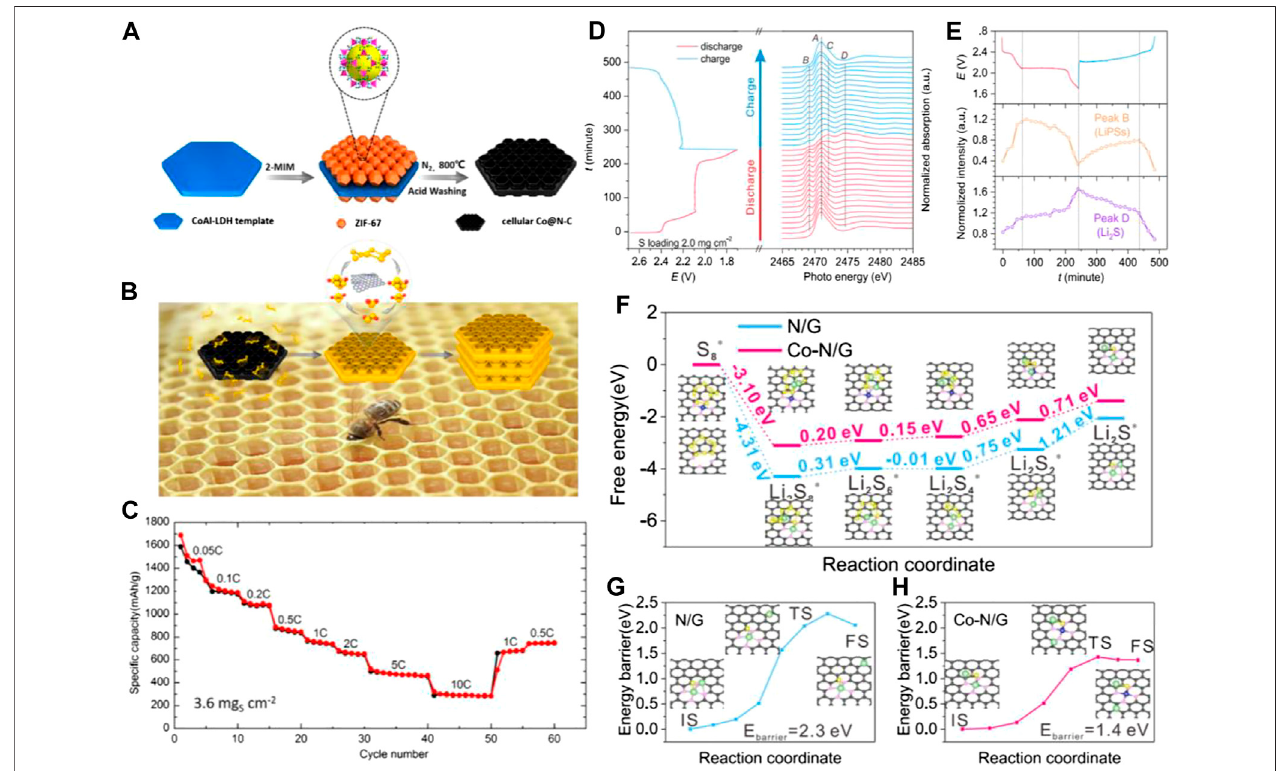
FIGURE 2 | (A) Schematic illustration of the step-by-step synthesis strategy for the cellular Co@N − C composite (B) the schematic illustration of the cellular Co@ N − Ccomposite which catalyzed theformationand thedecomposition ofLi 2 Sinthe discharge and charge process (C) Rate performances ofthe 90 S/cellular Co@N − C at different current rates. Reproduced with permission from Li et al. (2017). Copyright © 2017 American Chemical Society (D) Evolution of S K-edge XANS during electrochemical cycling (E) evolution of the intensities of peak B (2,469.0 eV, representing concentration of LiPSs) and peak D (2,474.7 eV, representing Li 2 S concentration) during electrochemical cycling (F) Energy pro fi les for the reduction of LiPSs on N/G and Co-N/G substrates, energy pro fi les of the decomposition of the Li 2 S cluster on N/G (G) and Co-N/G (H) . The black, yellow, green, pink, and dark blue balls represent C, S, Li, N, and Co atoms, respectively. Reproduced with permission from Du et al. (2019). Copyright © 2019 American Chemical